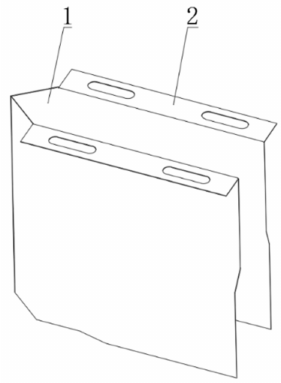
Figure 7. Ditching depth parts: 1. Ditching piece; 2. Connecting